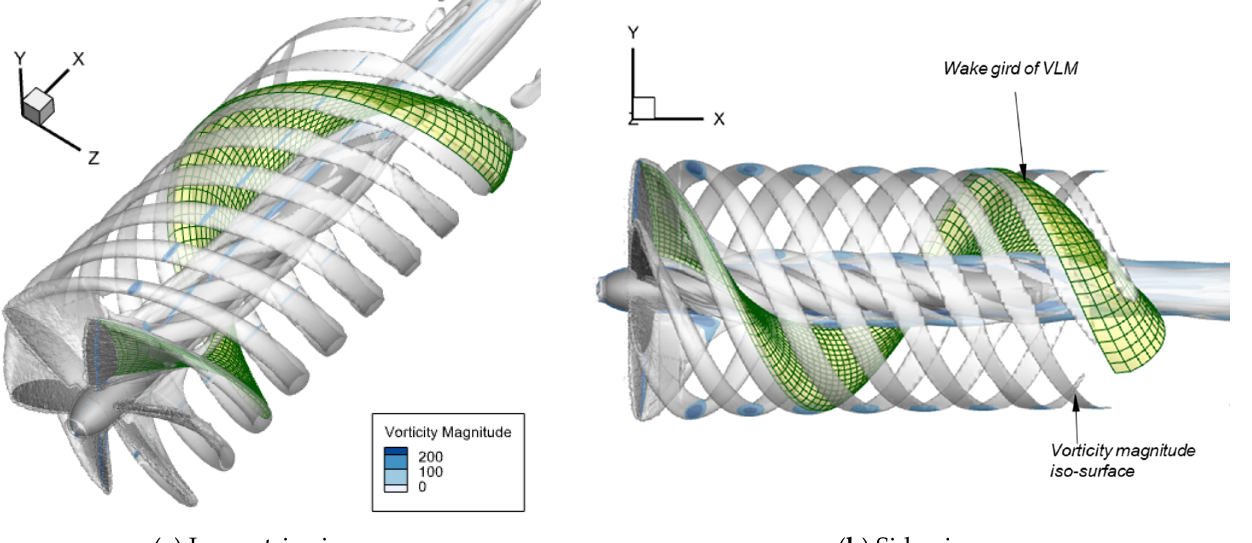
Figure 20. Propeller wake with an iso-surface of vorticity magnitude calculated by the RANS simulations, and wake panel calculated by the VLM at variable pitch angle = 34° and advanced ratio = 1.20.